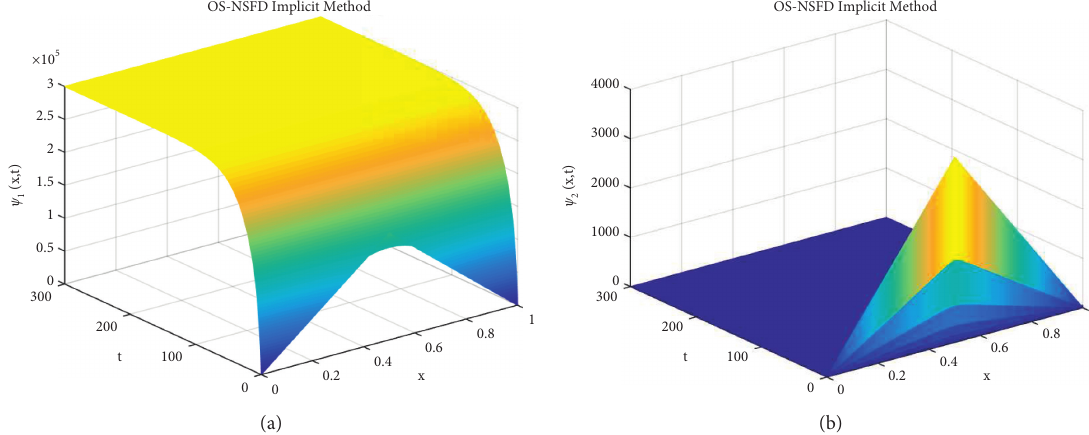
Figure 13: Solution graphs of ψ � λ � 125. (a) Solution graph of ψ κ � 0 . 002 , λ 1 2